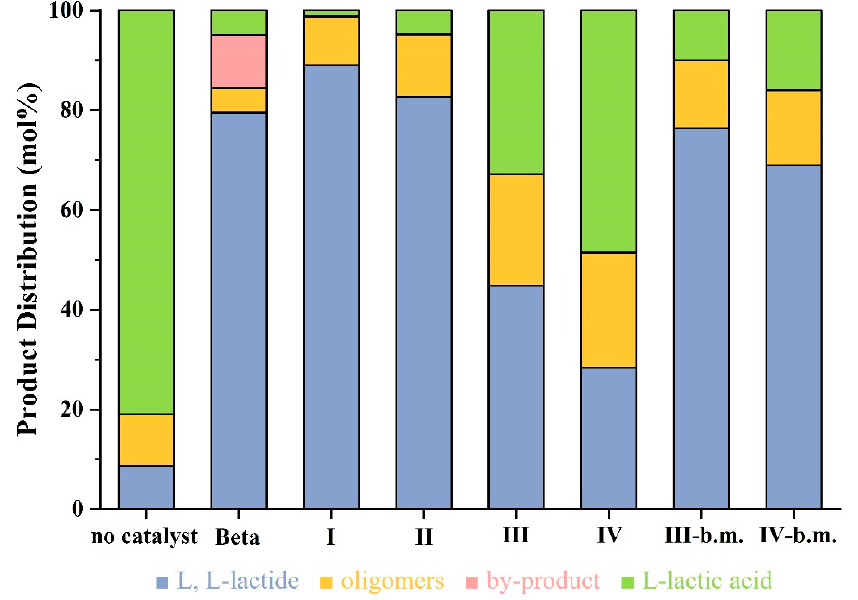
Figure 4. The product distribution of L-lactic acid to L, L-lactide over the ZSM-5 zeolites.